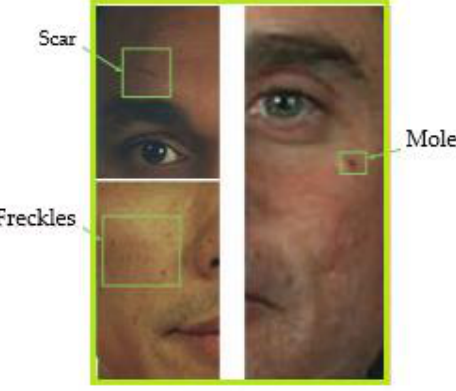
Figure 45. Soft biometrics: facial marks (freckles, mole, and scar).